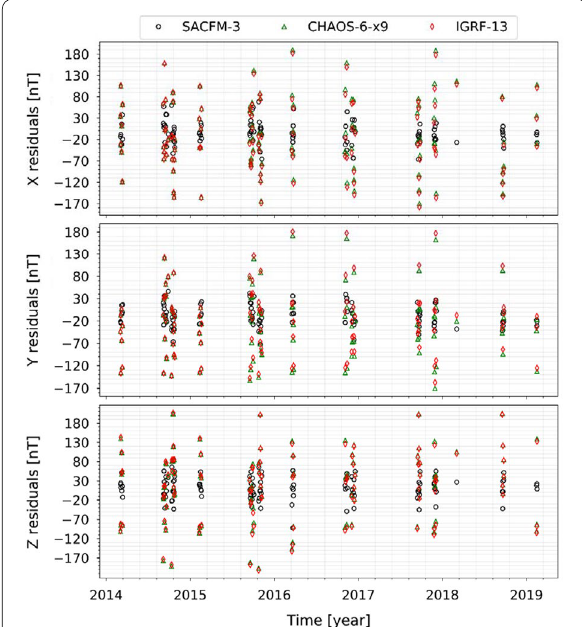
Fig. 2 Residuals of the differences between ground field survey data and models SACFM-3, CHAOS-6-